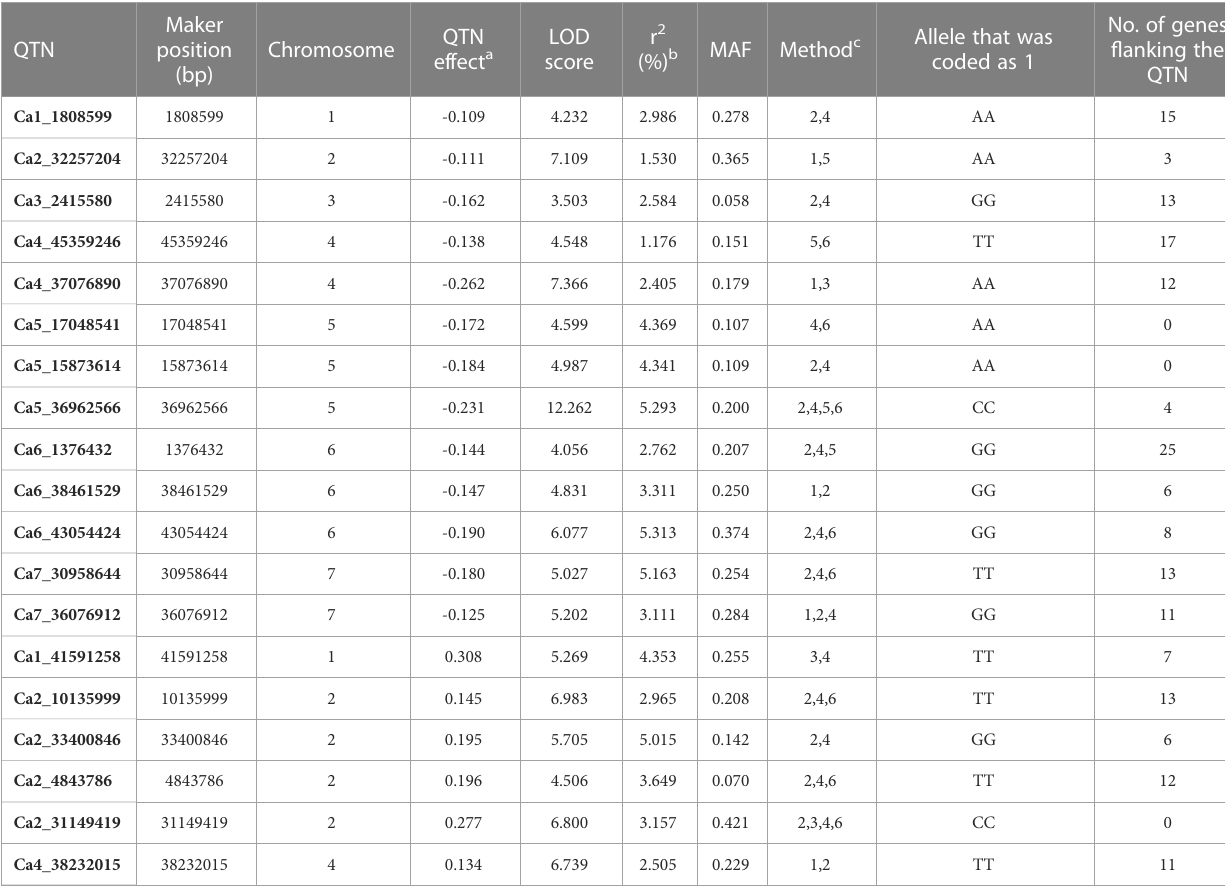
TABLE 2 The signi fi cant quantitative trait nucleotides (QTNs) for Pratylenchus thornei resistance or susceptibility in chickpea detected by two or more multi-locus GWAS methods. Maker QTN